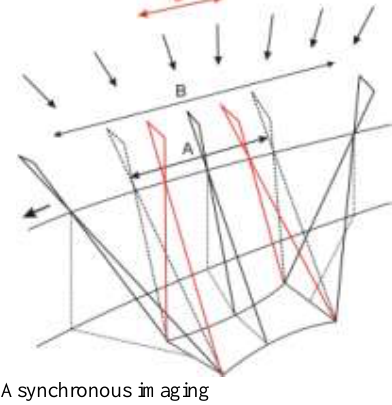
Figure 2. Asynchronous imaging